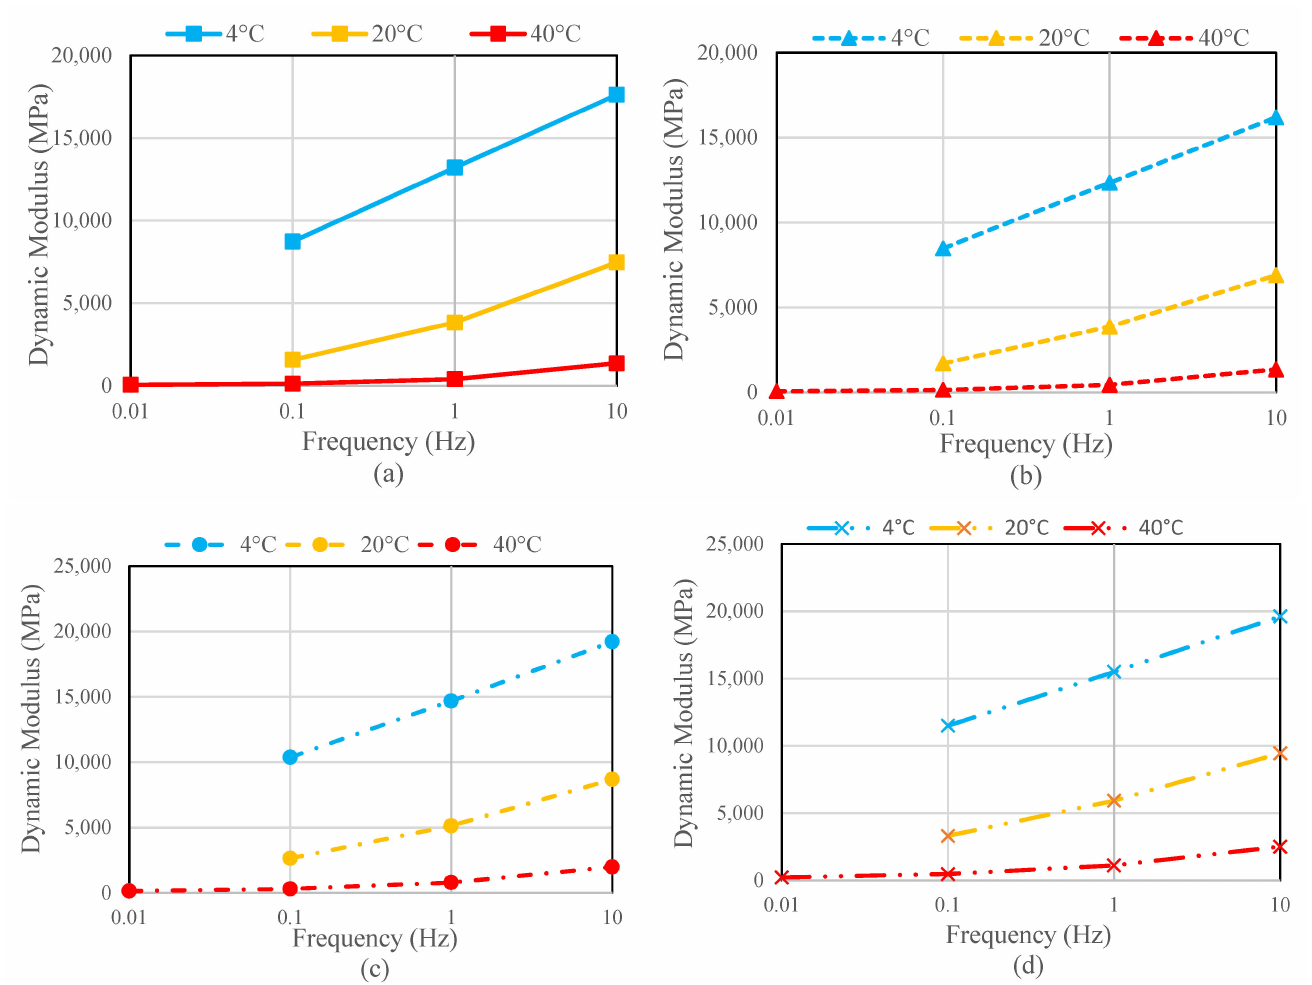
Figure 10. Dynamic modulus results: ( a ) HMA samples; ( b ) WMA with 1.5% Sasobit; ( c ) WMA with 3% Sasobit; ( d ) WMA with 6%